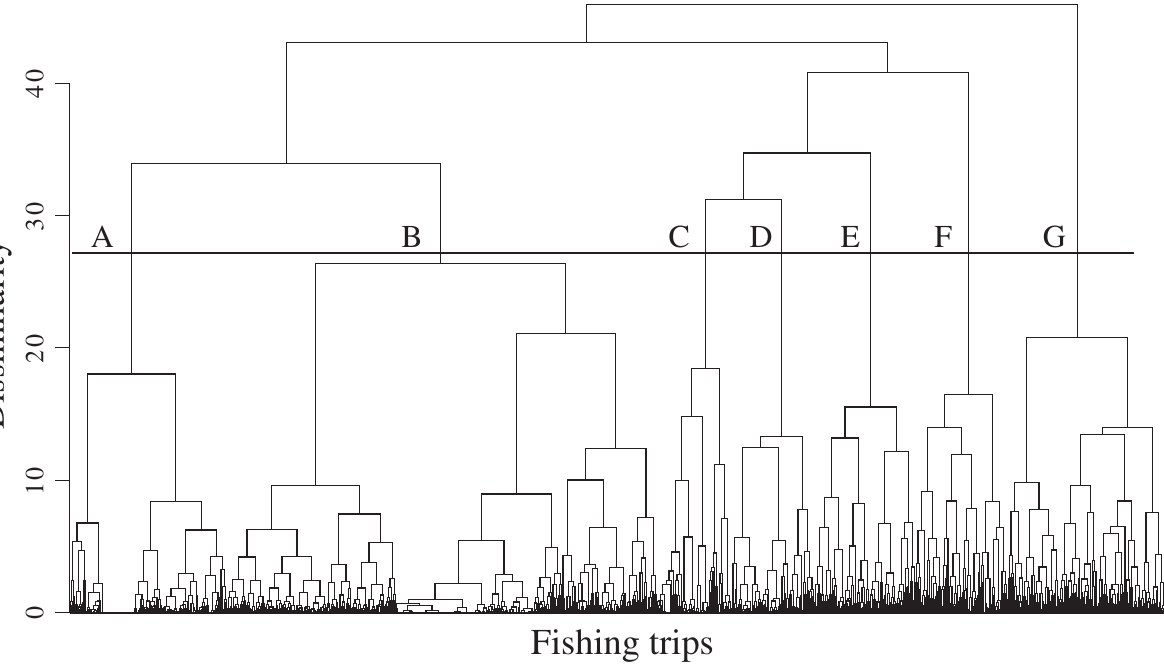
Fig . 4. – Dendrogram of the boat seine fishing trips in the aegean Sea, based on the log-transformed landings profiles.